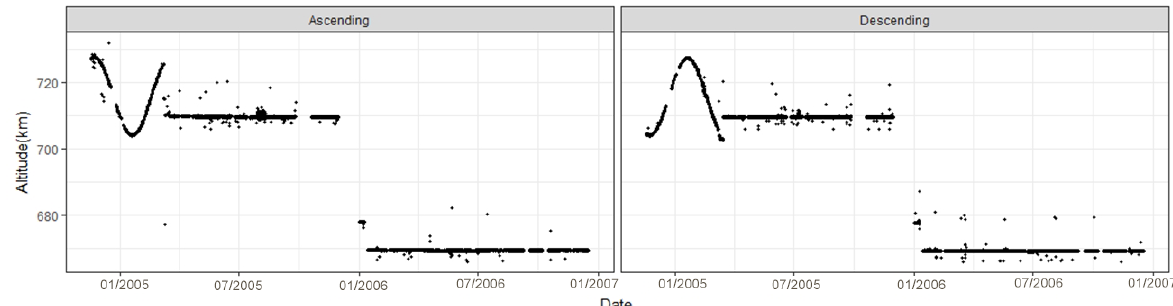
Figure 1. Average altitude of the DEMETER satellite from November 2004 to December 2006.